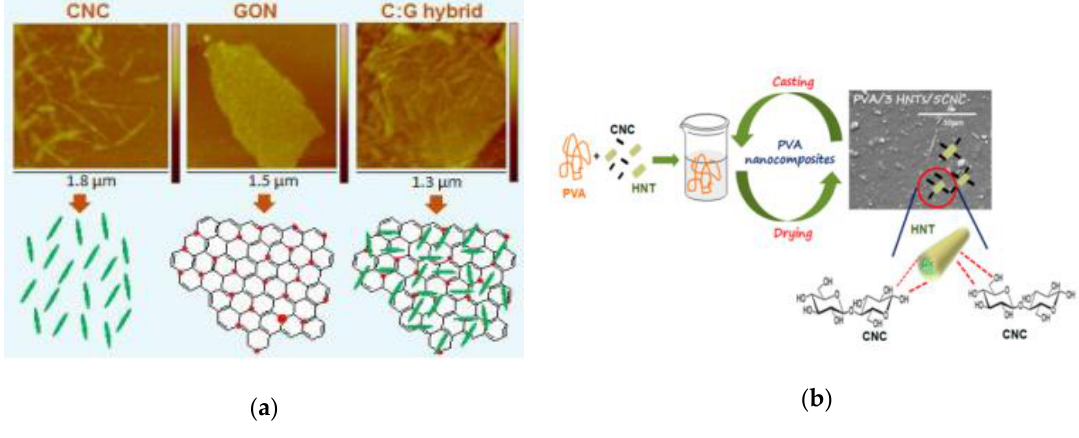
Figure 1. ( a ) Electron microscopy image and schematic diagram of CNC, GON and C: G (C:G = 1:2) mixed particles (red dot: oxygen-containing group in GON). Reprinted with permission from [85].